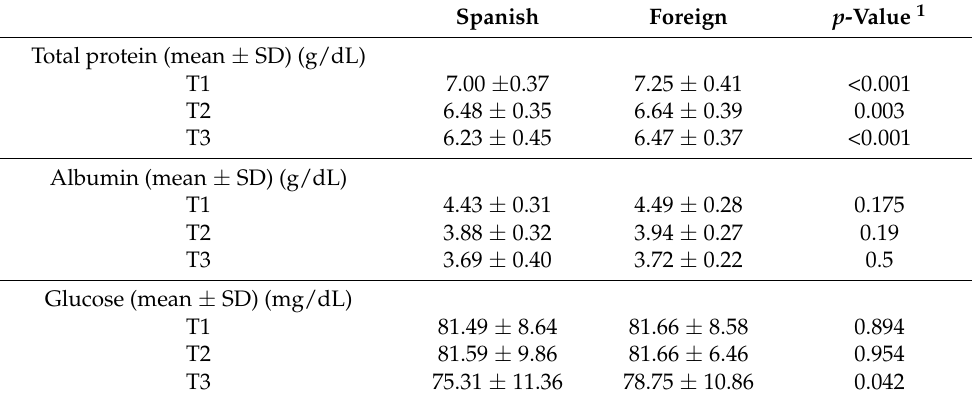
Table 3. Biochemical parameters in pregnant women included in the